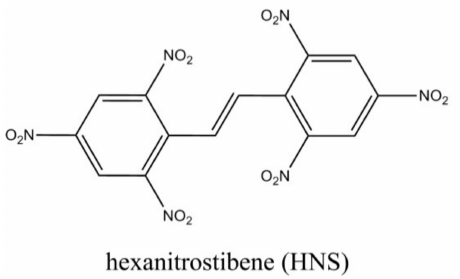
Figure 1. The chemical structure of the hollow spherical hexanitrostibene